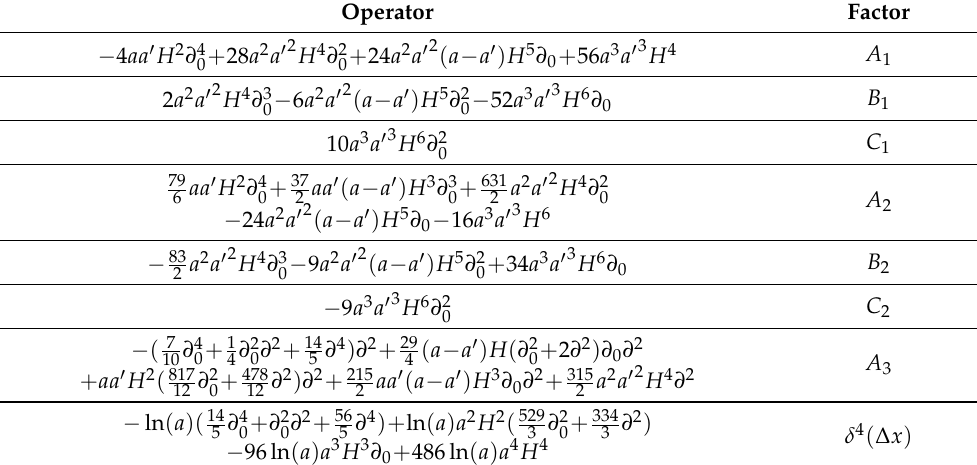
Table 11. Contributions for 9 iT 1 + 3 i 2 + 3 ( iT 3 + iT 4 )+ iT 13 . Each tabulated term must be multiplied by κ 2 . 32 π 3